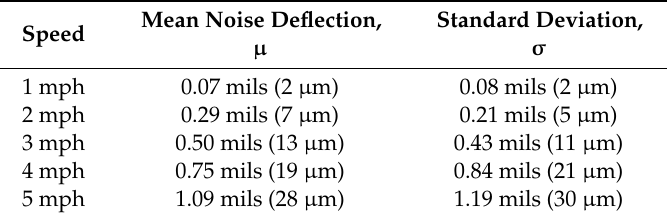
Table 2. Statistics of noise-level deflection measurements.